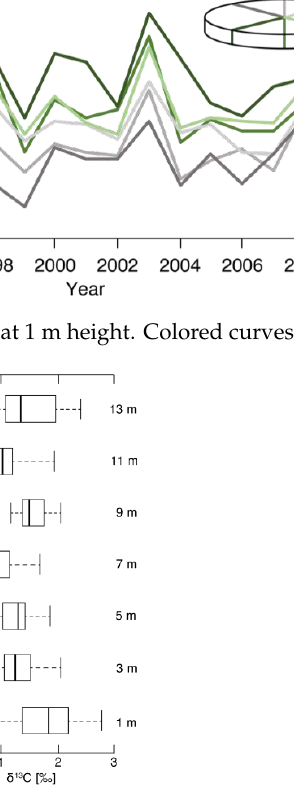
Figure 3. Circumferential δ 13 C variability along the larch trunk. The box plots indicate the maximum and minimum values (whiskers), the lower and upper quartiles (box), and the second quartile (median) of intra- ring δ 13 C variability among radii A – F.